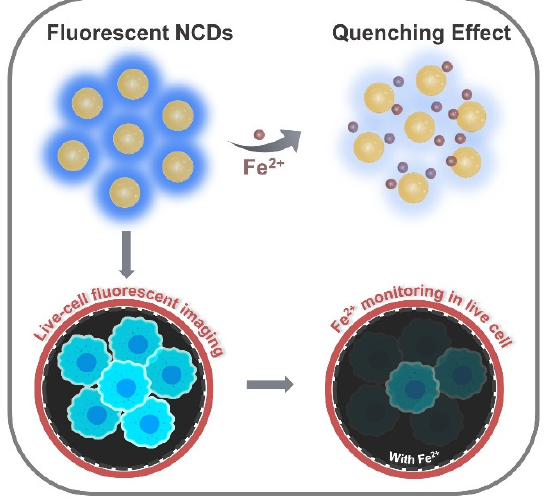
Figure 1. Representation of fluorescence quenching effect of ferrous ions on CDs and their applica- tion in intracellular Fe 2+ ion